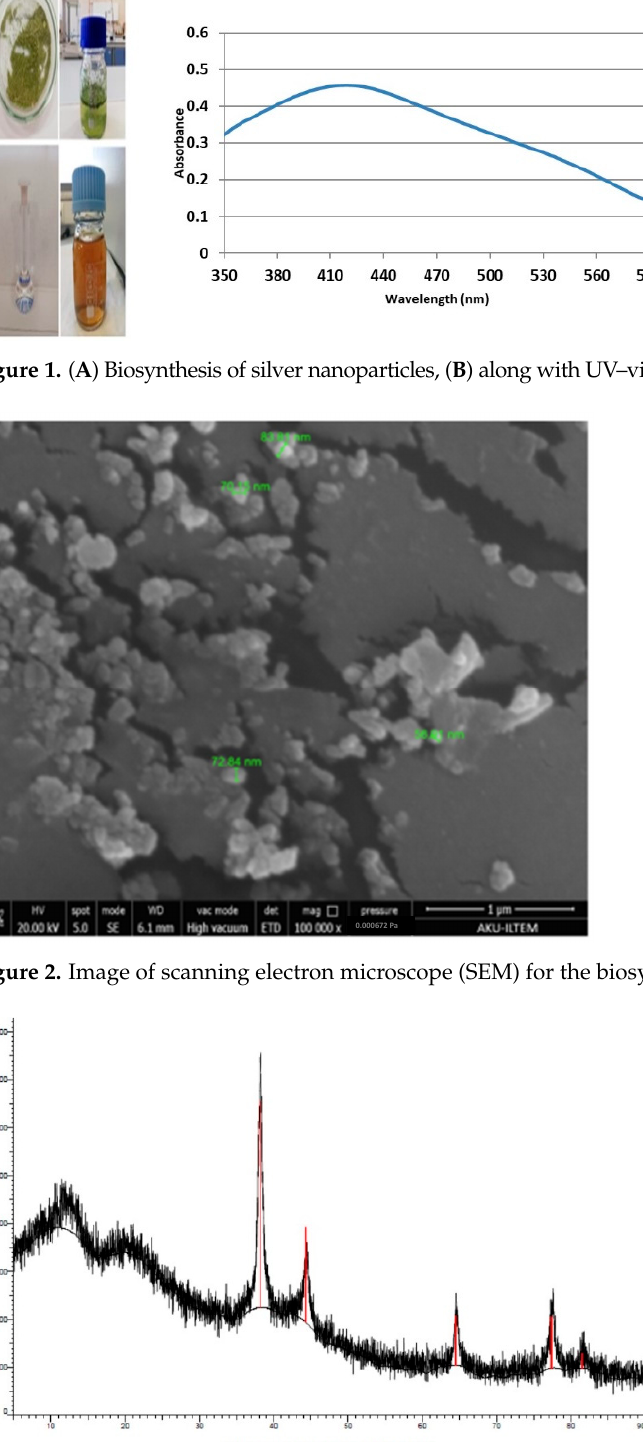
Figure 3. Image of X-ray diffraction for the biosynthesized